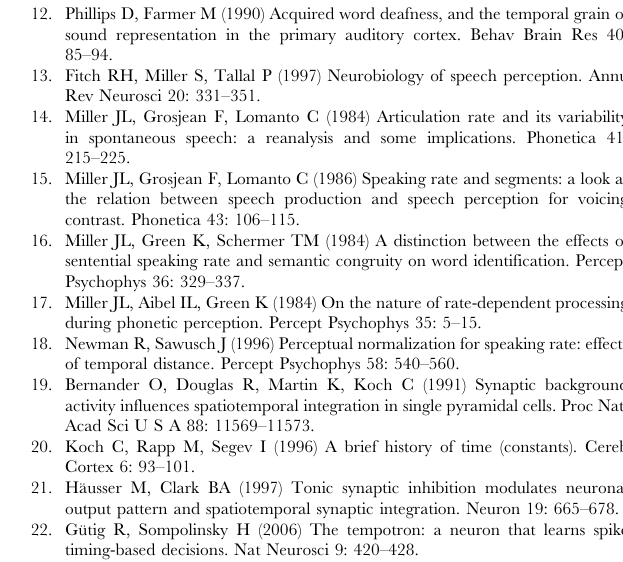
Table S1 Generalization from TI46 to TIDIGITS. For each dialect group, the table lists the percentages of speakers for which our model committed a given number of word-recognition